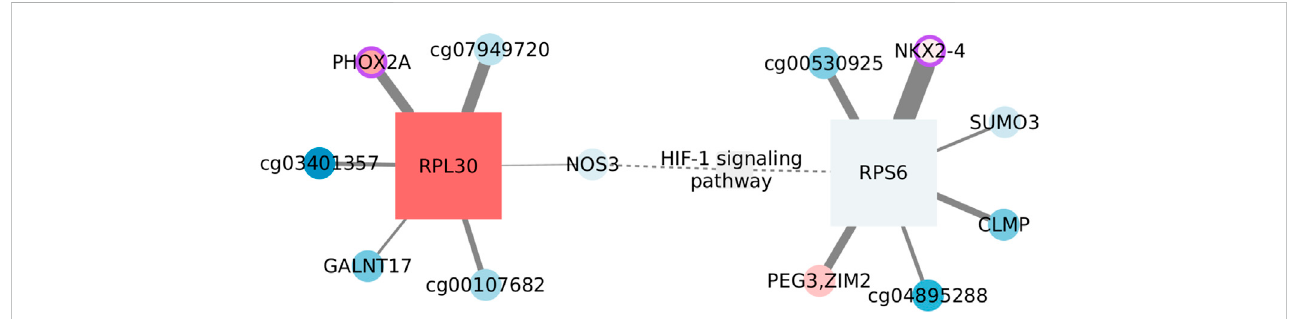
FIGURE 5 Features connected with HIF-1 signaling in the basal subtype. Circles represent CpGs, and squares are transcripts. When possible, CpGs are identi fi ed with the symbol of the gene they affect; otherwise, the ID of theprobeis used. The shades of red indicate thelevel of overexpression/methylation against the normal tissue, while blue tones represent values under what is expected. The node size re fl ects its degree. A purple border identi fi es nodes whose protein playsatranscription factorrole.The weight ofthelinkistheextentofmutualinformationbetweenconnected nodes.Dashed edgeslinkMIcomponents with prior information.